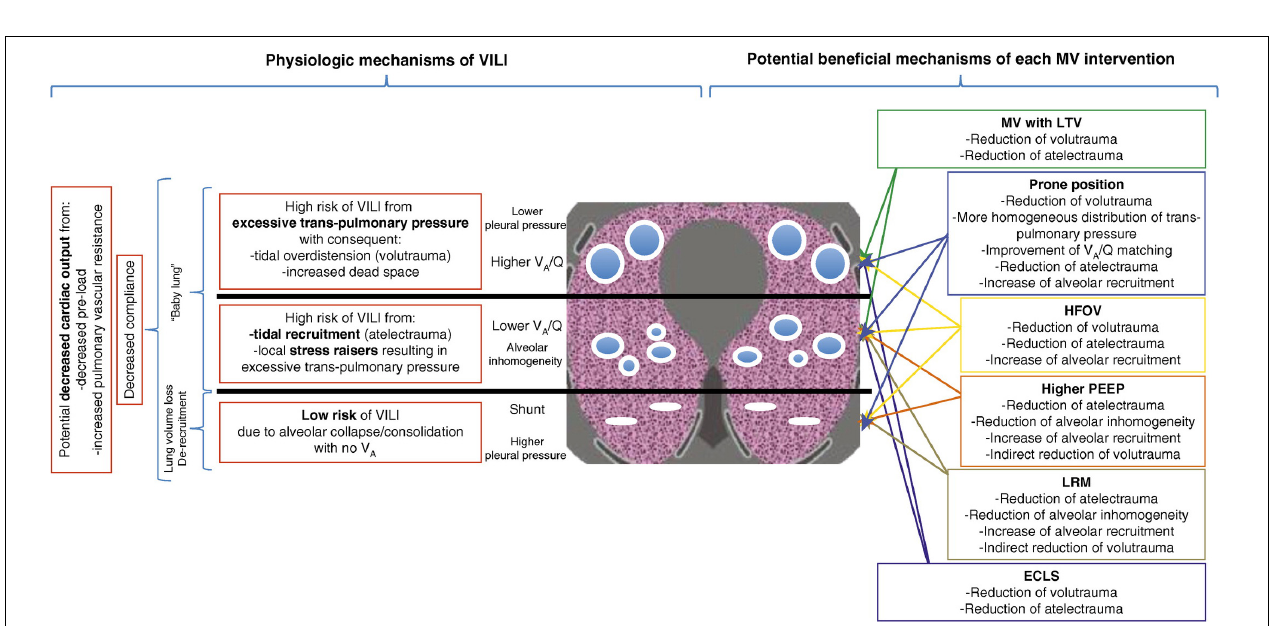
FIGURE 2 | Gravity dependent three-compartment model of acute respiratory distress syndrome (ARDS) pathology: Left – Physiological mechanisms of ventilator-induced lung injury (VILI) and Right – Potential beneficial mechanisms of various protective ventilation strategies to minimize VILI. Open alveoli are shown as blue circles similar in size (top), unstable alveoli as smaller circles of various sizes (middle), and collapsed alveoli as solid white lines (bottom). The ARDSnet low tidal volume (LVt) method is designed to protect compliant open alveoli in the non-dependent lung and rest the collapsed tissue in the dependent portion of the lung by keeping it unventilated. Positive end-expiratory pressure (PEEP) is added in an attempt to stabilize the alveoli in between (Acute Respiratory Distress Syndrome Network, 2000). High-frequency oscillatory ventilation (HFOV) and lung recruitment maneuvers (LRMs) have been shown ineffective in reducing ARDS mortality (Brower et al., 2004; Meade et al., 2008; Mercat et al., 2008; Ferguson et al., 2013; Young et al., 2013; Cavalcanti et al., 2017; Hodgson et al., 2019). Prone position has been shown effective at reducing mortality (Guerin et al., 2013) by a mechanism of reducing regional alveolar strain and inflammation (Motta-Ribeiro et al., 2018; Xin et al., 2018). VILI, ventilator-induced lung injury; MV, mechanical ventilation; LTV, low tidal volume and inspiratory pressure; PEEP, positive end-expiratory pressure; ECLS, extracorporeal life support; HFOV, high-frequency oscillatory ventilation; LRM, lung recruitment maneuver; Q, perfusion; V A , alveolar ventilation; V A /Q, ventilation/perfusion ratio; baby lung, functional residual capacity (FRC) (Del Sorbo et al., 2017). Permissions to publish obtained from ATS.